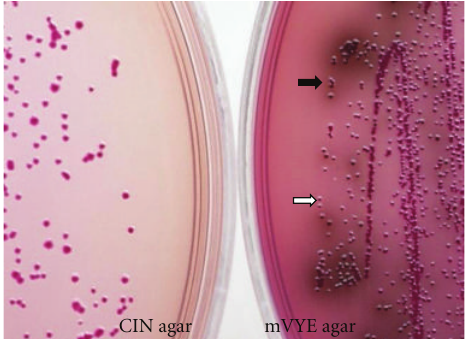
Figure 3: Colonies of Y. enterocolitica grown on CIN agar and mVYE agar incubated at 30 ◦ C for 24 h. Yersinia colonies on CIN form the characteristic deep red center (“bull’s eye”) with a transparent margin and diameter 2–4mm. Pathogenic Y. entero- colitica serotype O:3/biotype 3 variant VP − (white arrow) forms red colonies and is easily di ff erentiated from most nonpathogenic Yersinia organisms (black arrow) and other Gram-negative bacteria, which form dark-red colonies with a dark peripheral zone as a result of mannitol fermentation and esculin